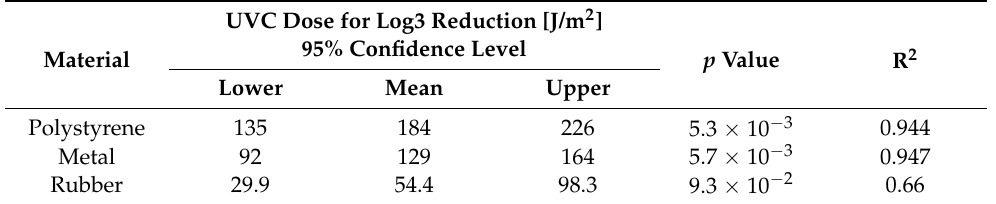
Table 1. Summary of Linear Regression Model.